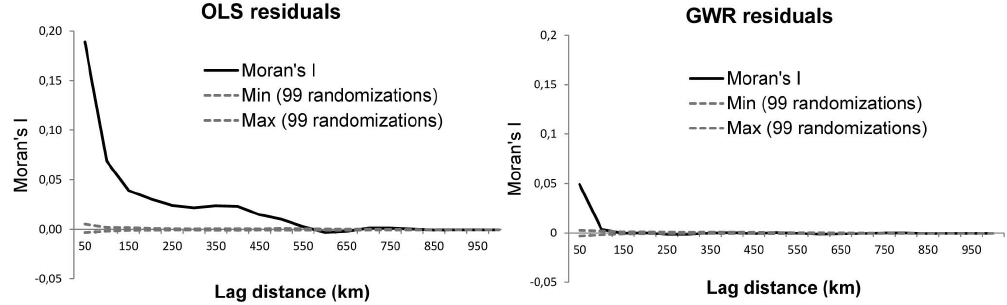
Fig. 8. Spatial correlograms of the residuals of the OLS linear regression (left) and GWR regression modelling